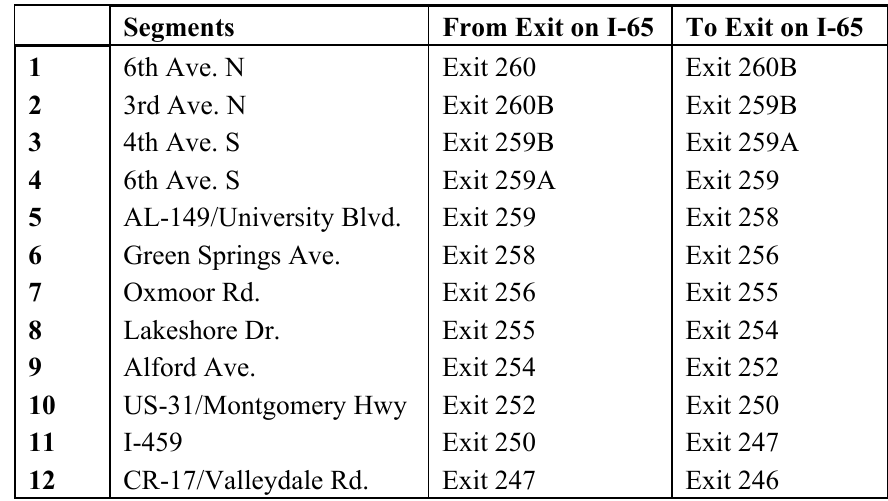
Table 4. I-65 study corridor